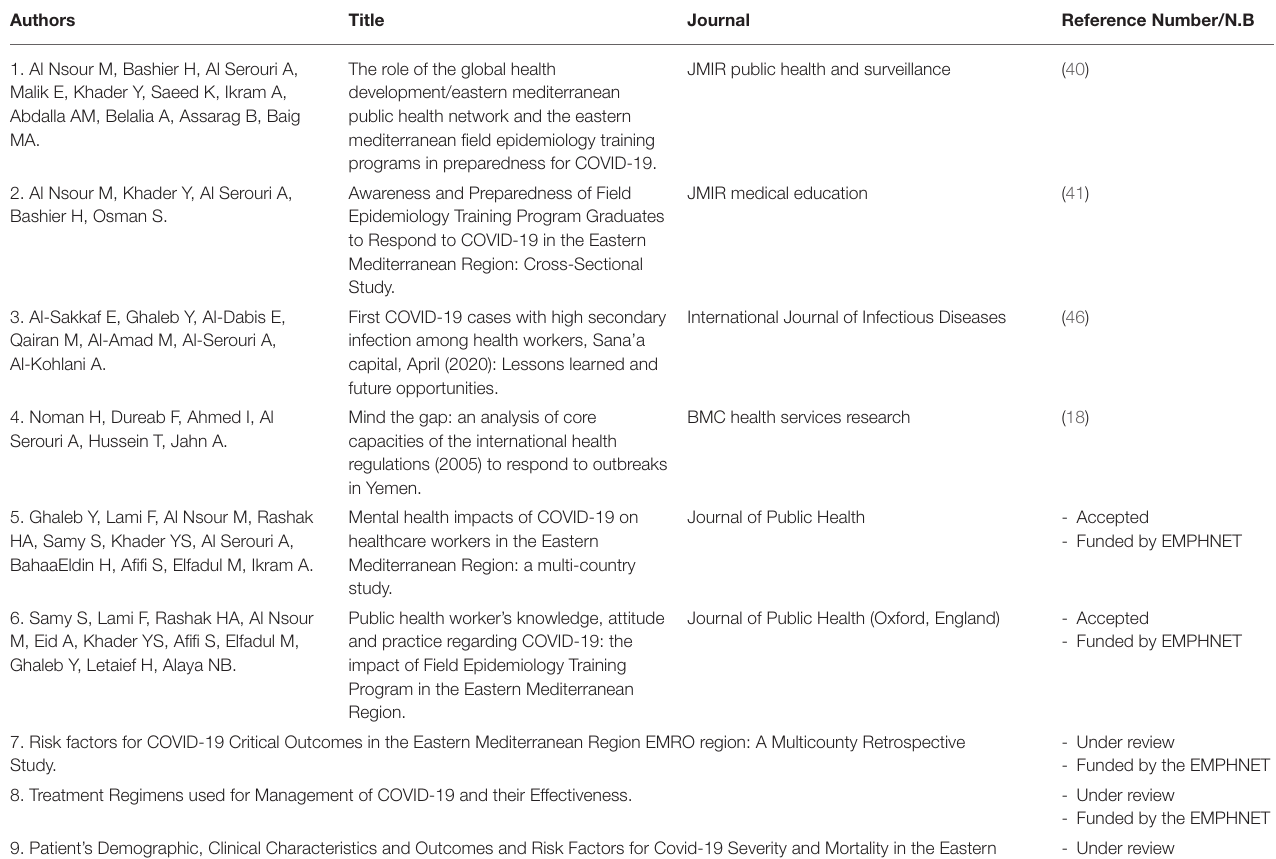
TABLE 3 | Yemen field epidemiology training program participation on COVID-19